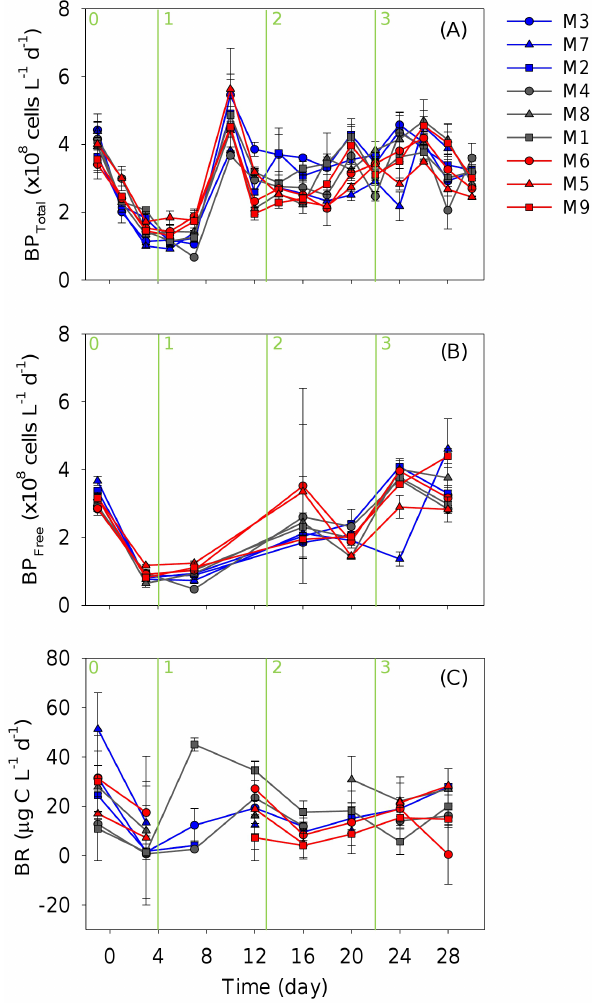
Fig. 1. Temporal variation of bacterial production estimated by TdR incorporation of unfiltered fraction (A) , of filtered fraction (B) and bacterial respiration (C) . Values are means ± stand deviations for triplicate measurements ( n = 3). Circles represent mesocosms M3, M4 and M6; triangles M7, M8, M5; and squares M2, M1 and M9, respectively. Low, medium, and high p CO 2 treatments are coloured in blue, grey, and